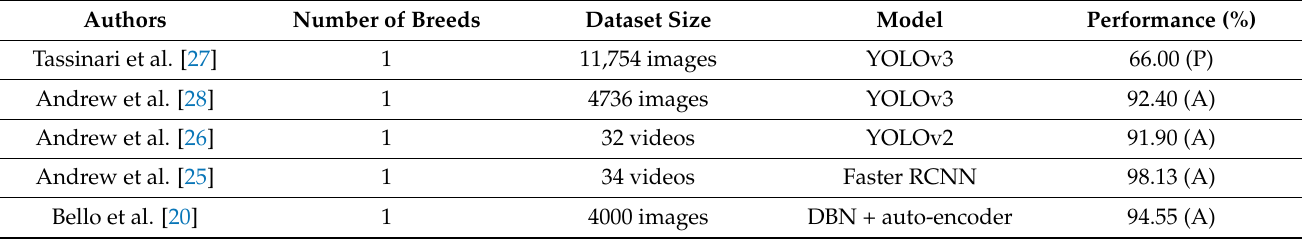
Table 1. Deep-learning-based cow breed detection